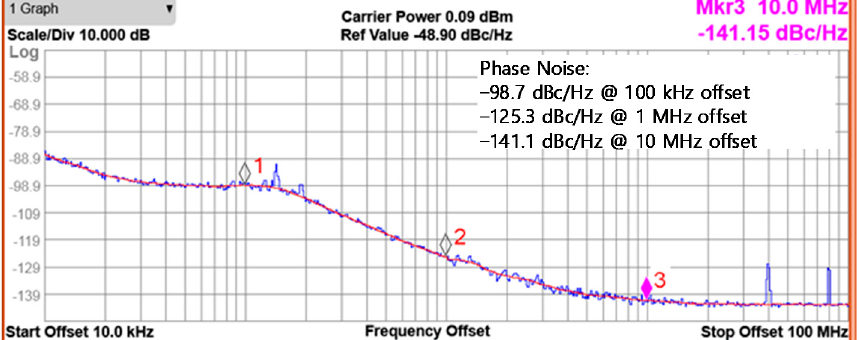
Figure 11. Measured phase noise of the PLL synthesizer. The IM2 calibration is verified through extensive measurements over more than five samples. All results show reasonably good agreements with acceptable variability. Figure 12a shows the measured spectrum, demonstrating how the IM2 distortion is suppressed by the proposed IM2 calibration. The desired RF single tone of − 90 dBm at 403.5 MHz are fed to the receiver together with two-tone blocker of − 50 dBm at 433.0 and 433.2 MHz. The receiver is set to a nominal gain condition. Then, the wanted IF and unwanted IM2 tones appear at 300 kHz and 200 kHz, respectively. Before the IM2 calibration, the desired and distortion tones are − 47.8 and − 48.5 dBm, respectively. After the IM2 calibration is carried out, the desired tone power does not show a noticeable change, whereas the IM2 tone power is significantly reduced from − 48.5 dBm to − 66.1 dBm. As a result, the signal-to-IM2-distortion ratio is improved from +0.7 dB to +18.3 dB. It implies that before the calibration, the receiver cannot satisfy the 14 dB SNR requirement, but after the calibration, it successfully satisfies the SNR requirement with a sufficient margin of 4.3